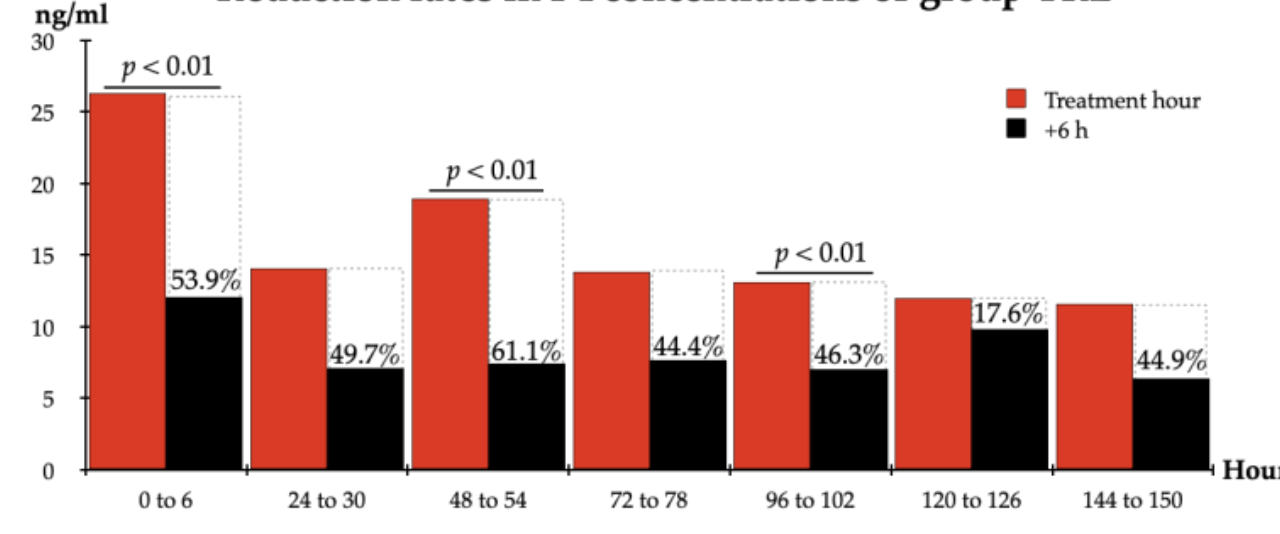
Figure 5. Reduction rates in P4 concentrations 6 h after each TRL treatment. TRL: trilostane; AGL: aglepristone; CON: control.